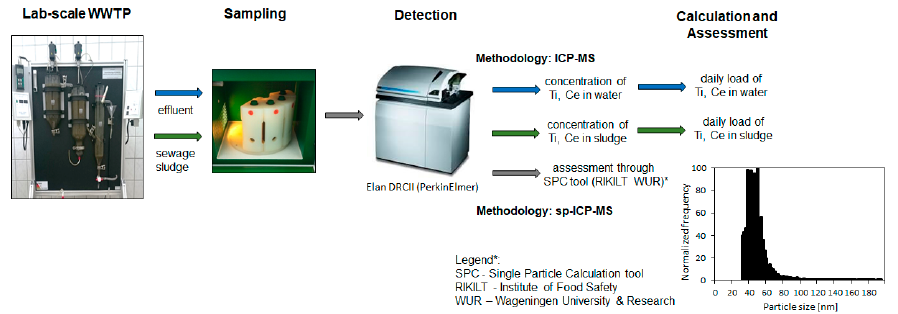
Figure 1. Investigation strategy for nCeO 2 and nTiO 2 on the pathway wastewater-sewage sludge.